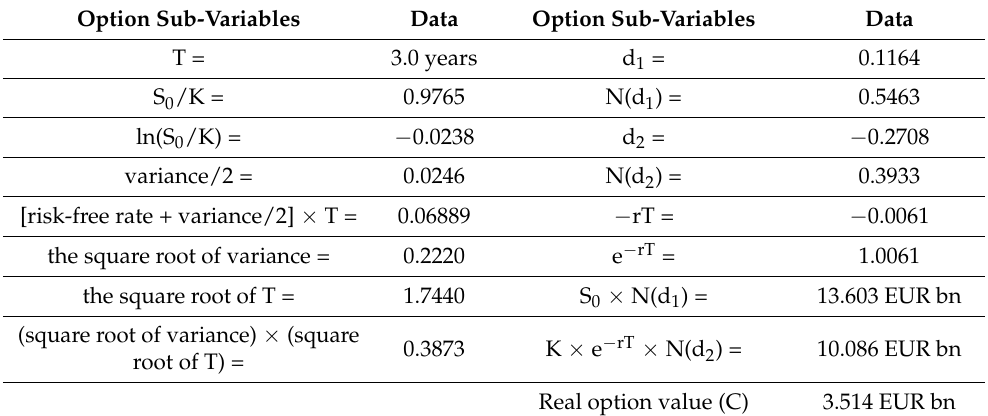
Table 5. Real option sub-variables of the Black–Scholes simple option pricing model to value the tacit competence-based synergies of the Ahold and Delhaize collaborative venture (in EUR